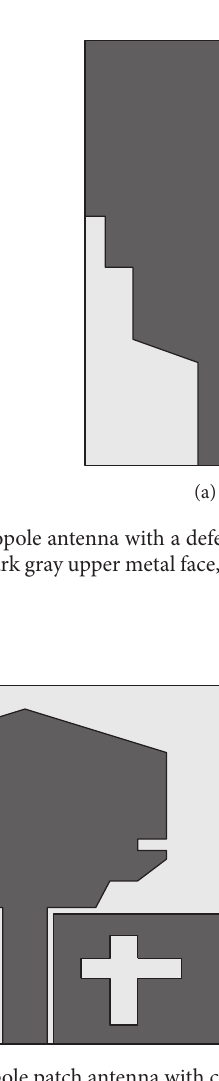
Figure 25: A CPW-fed monopole patch antenna with cross-shaped DGS [34]. The presence of the DGS structures is evident in the figure. Dark gray upper metal face and light gray dielectric